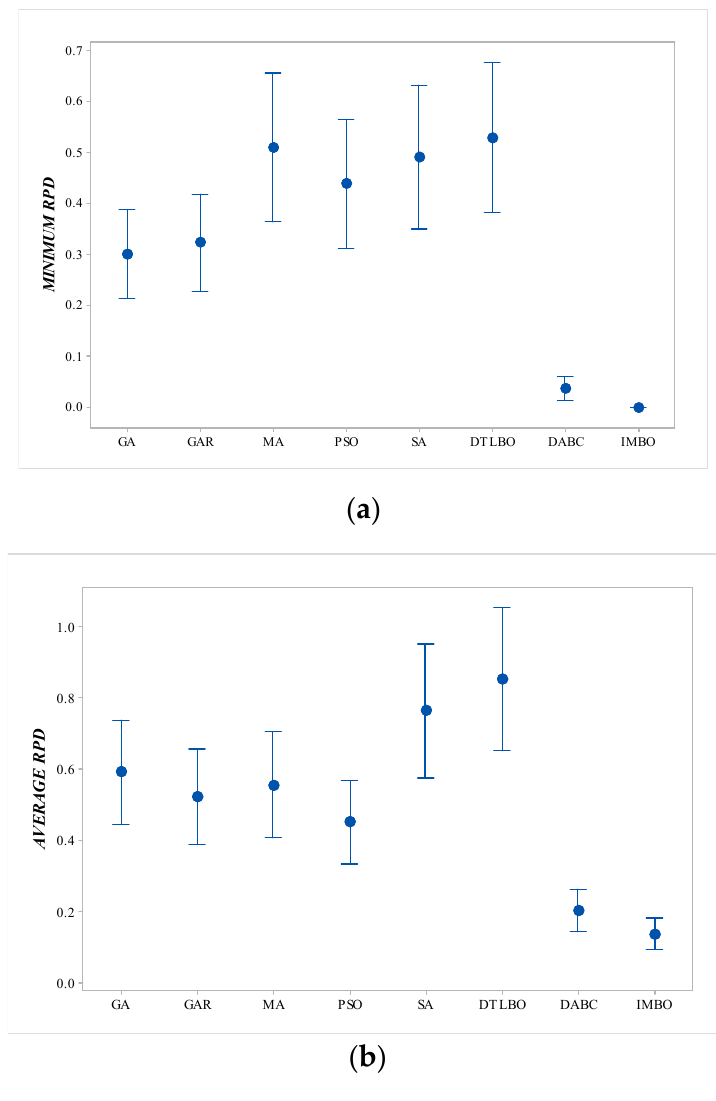
Figure 7. Means plots and 95% confidence intervals regarding the minimum RPD or average RPD when ρ = 20. ( a ) The value of minimum RPD by algorithms; ( b ) The value of average RPD by algorithms.